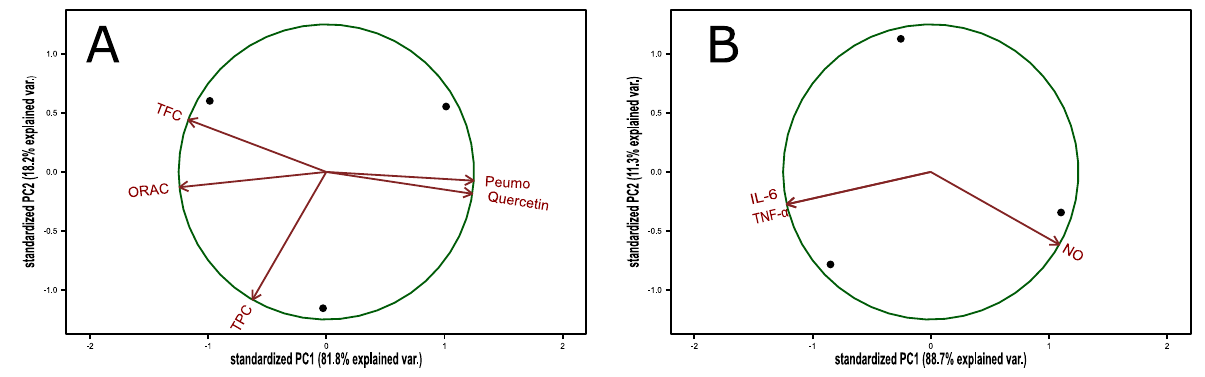
Figure A2. PCA biplot for antioxidant ( A ) and anti-inflammatory ( B ) indices of methanol peumo extract. Table A1. Correlation matrix for TEAC, TPC, FRAP, DPPH and TFC antioxidant capacity indices of three developing stages of Peumo. Harvest season 2017. Significance level of p -vales < 0.001 (***), 0.01 (**), 0.05 (*).